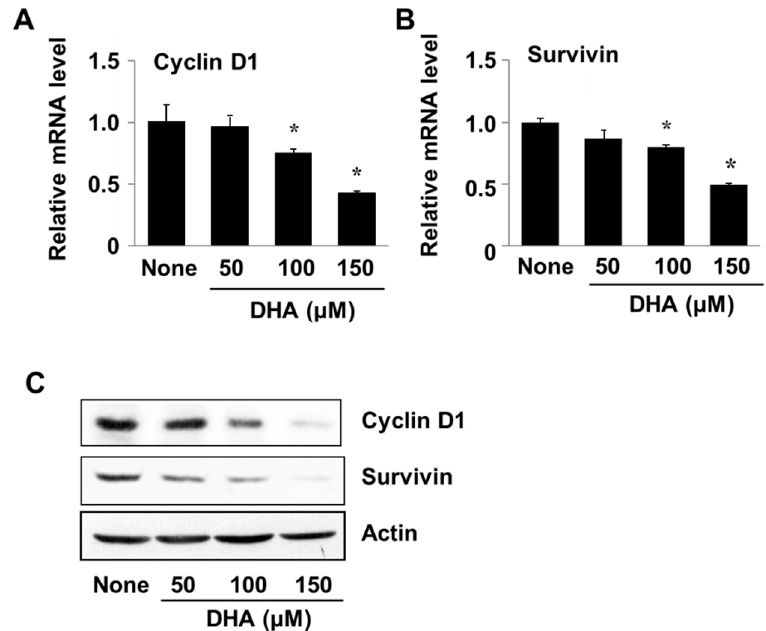
Figure 5. The effect of DHA on cyclin D1 and survivin gene expression in PANC-1 cells. Cells were treated with DHA for 24 h. ( A , B ) A plot of the relative levels of cyclin D and survivin messenger RNA (mRNA), determined by using real-time PCR analysis. * p < 0.05 vs. None. Column “None” corresponds to the untreated cell extract, column “50”, “100”, and “150”to the extracts of cells treated with 50, 100, and 150 µ M DHA, respectively. ( C ) Western blot detection of cyclin D and survivin. The description of the columns is the same as in ( A , B ).